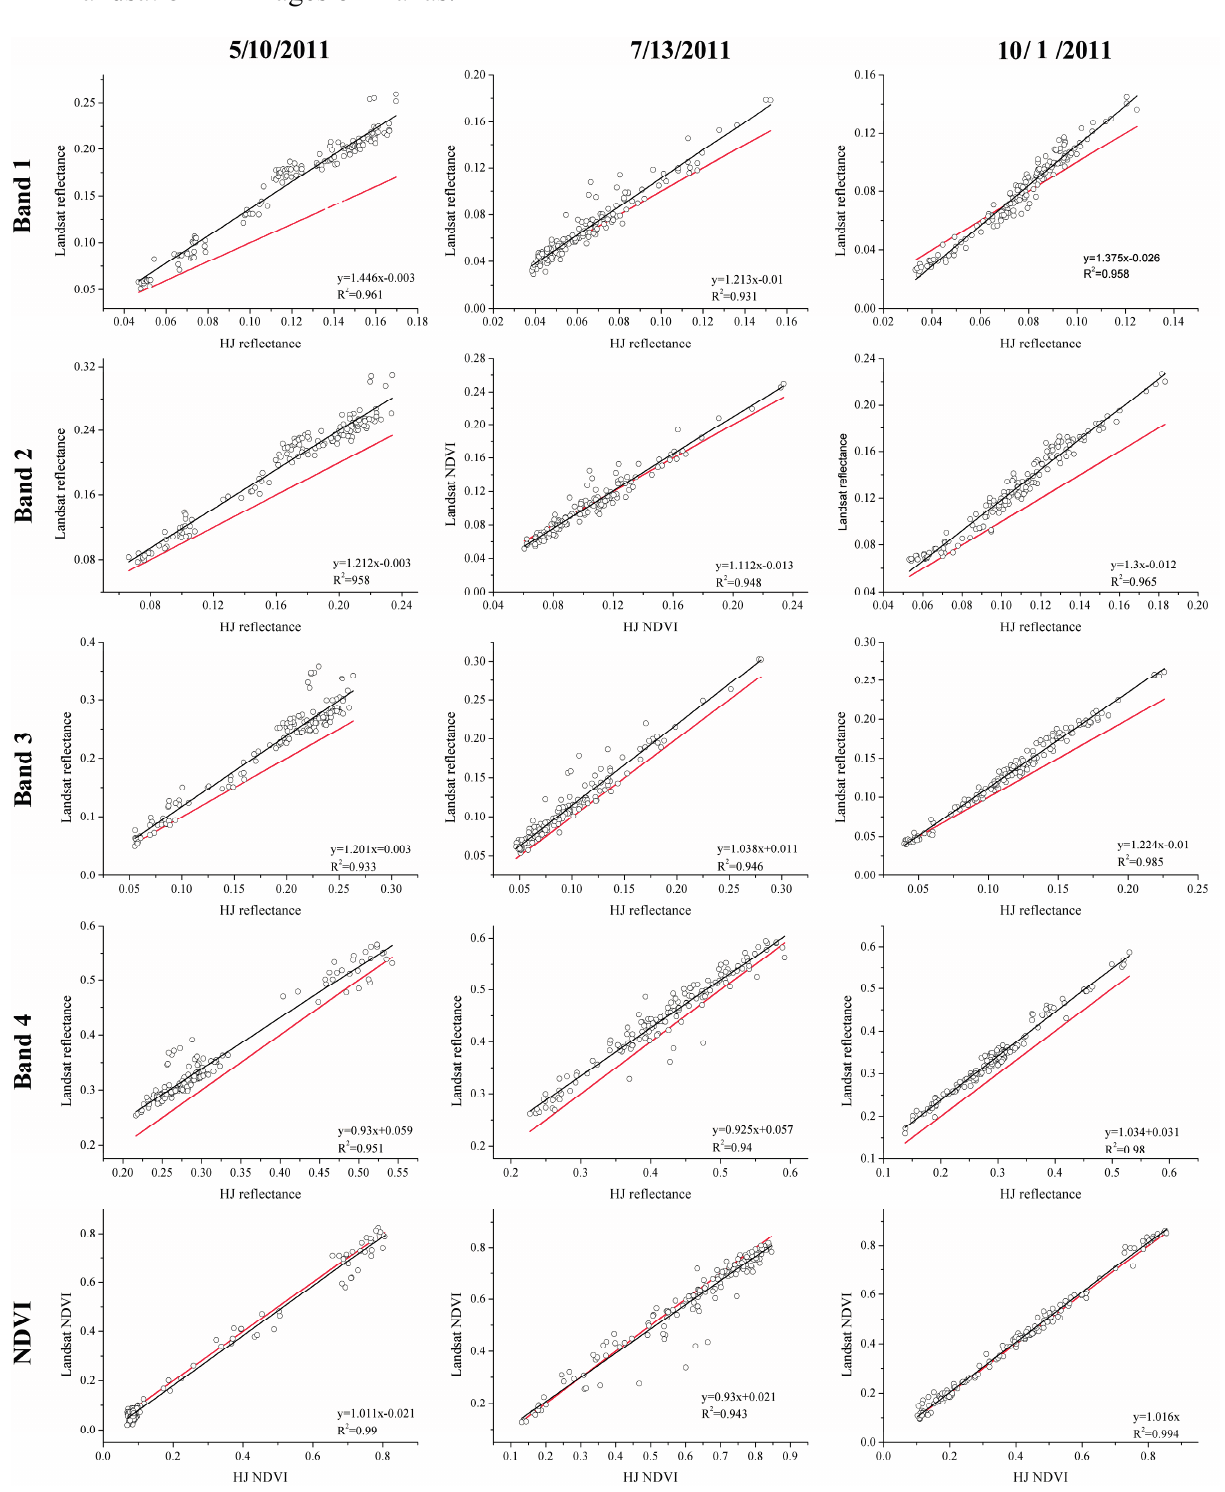
Figure 5. Scatter plots of land surface reflectance and NDVI data from HJ-1 CCD and Landsat-5 TM images of